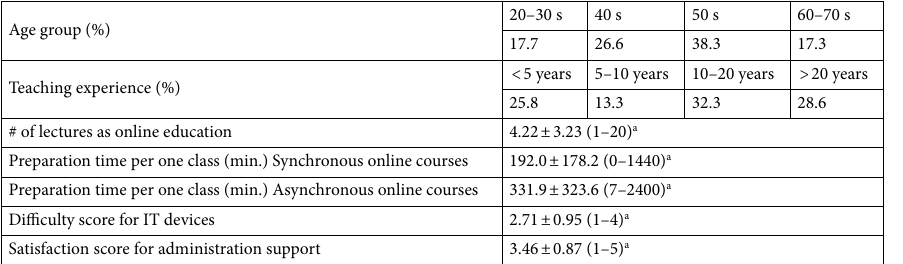
Table 1. Demographic characteristics. a Average ± standard deviation (range).